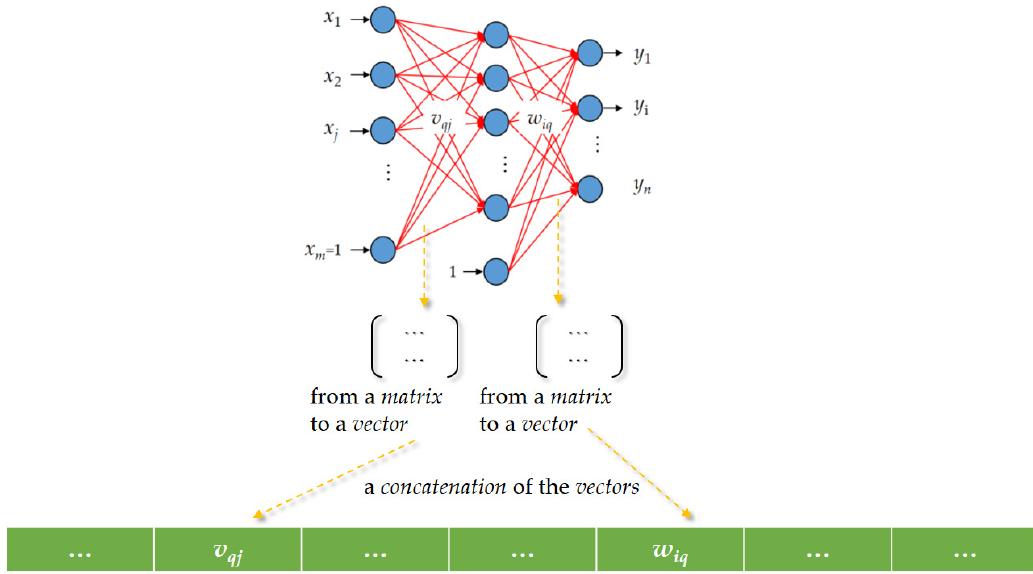
Figure 6. A chromosomal design encoding a feed-forward artificial neural network (ANN) as a chromosome. A chromosome (genotype) completely describes an ANN (phenotype).